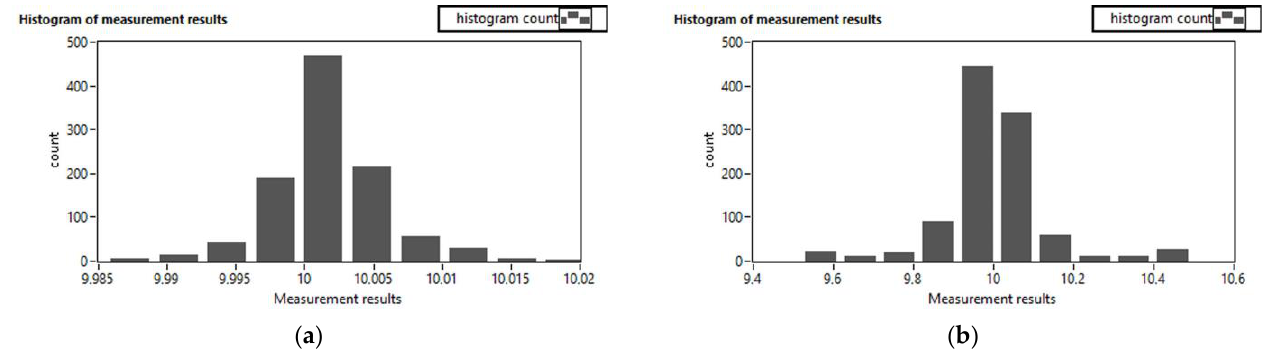
Figure 20. Histograms of individual results from a series of n = 1024 measurements made for the tested module NI USB-6341: ( a ) at low interference level, ( b ) at high interference level.